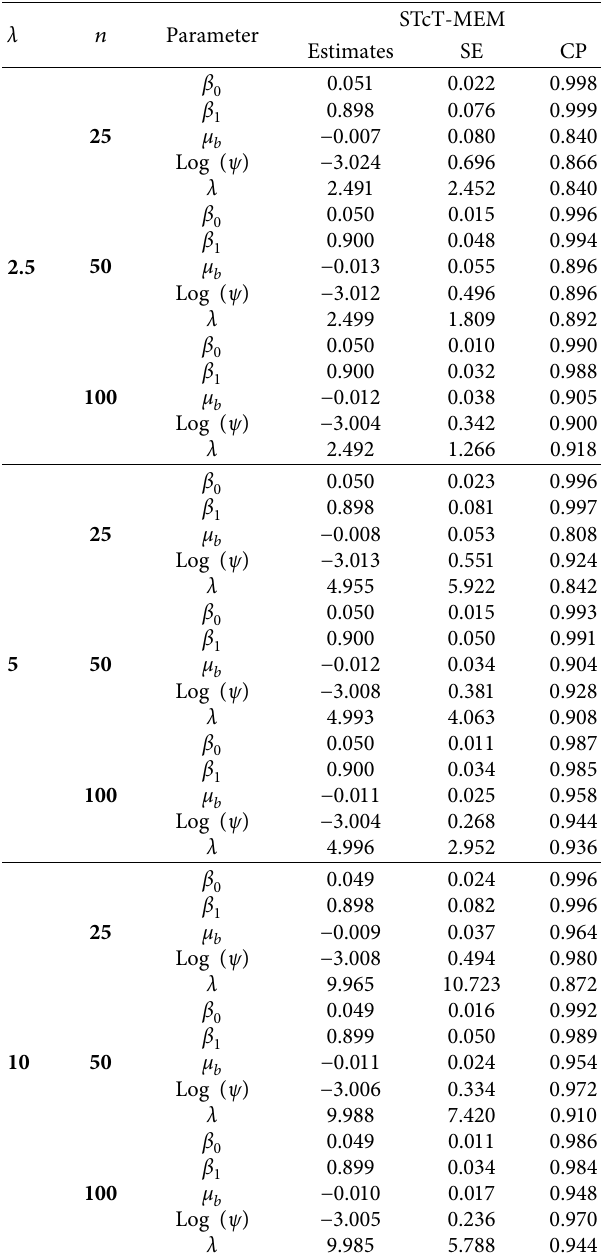
Table 1: ML estimates, asymptotic standard errors (SEs), and coverage probabilities (CPs) of 95% confdence interval of STcT-